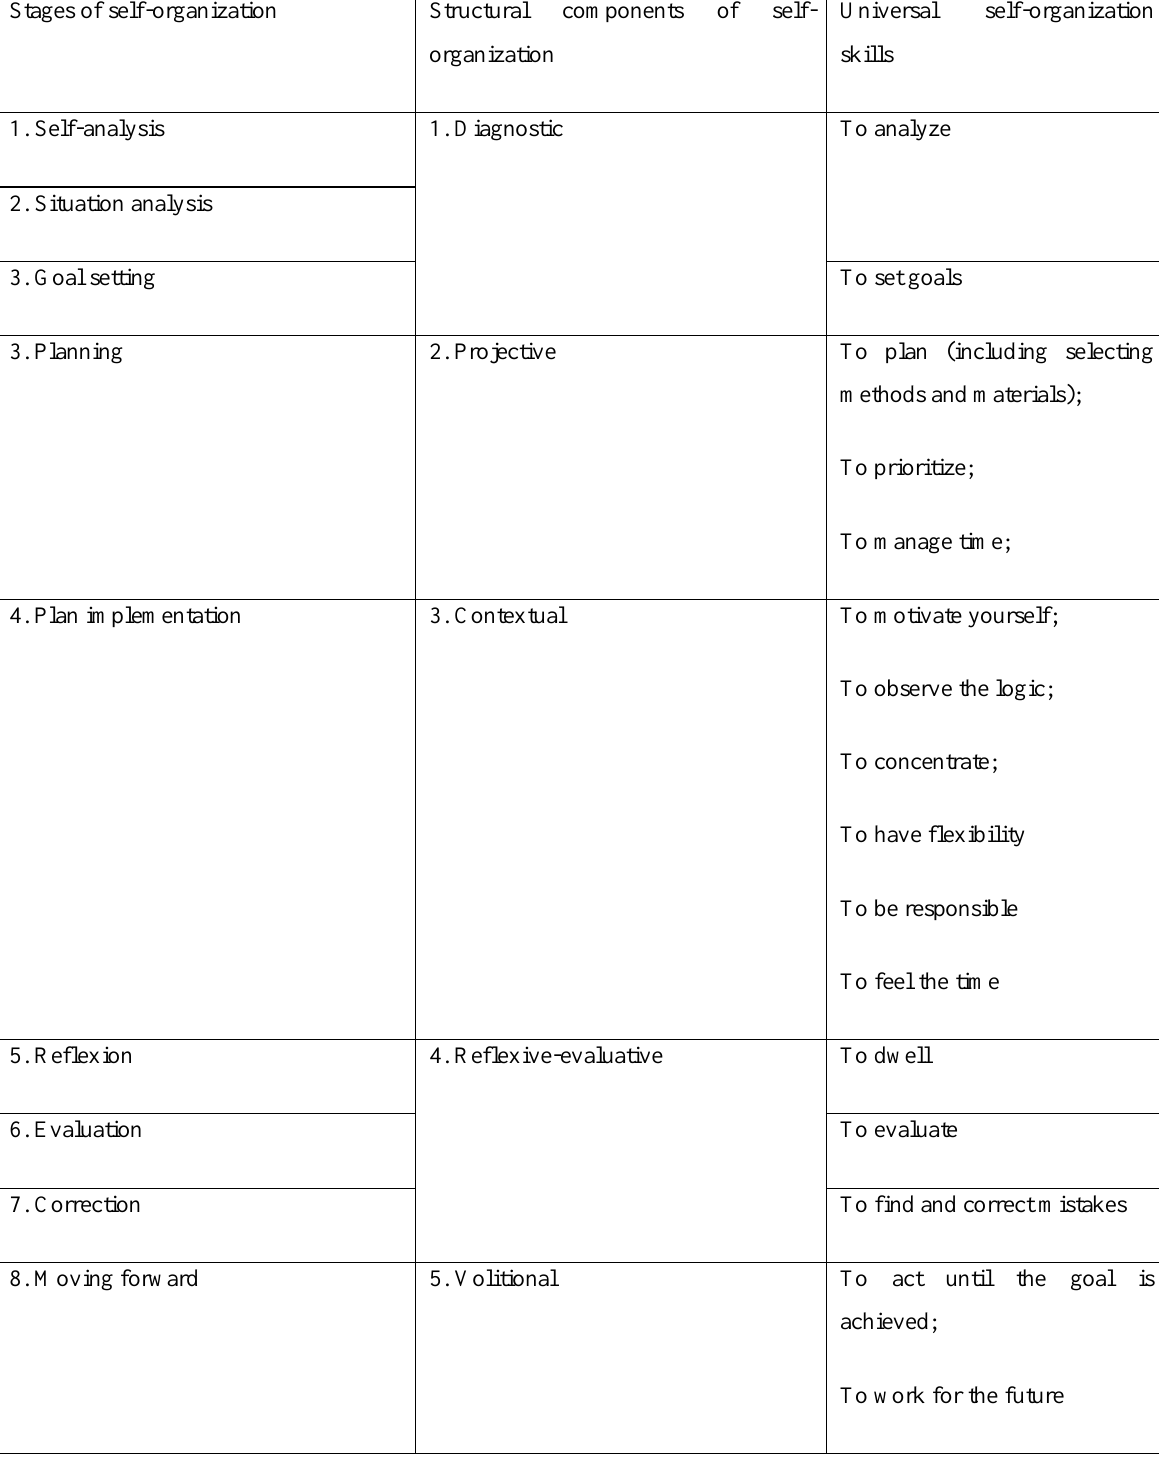
Table 2. The Structure of the Basic Skills of Self-Organization Stages of